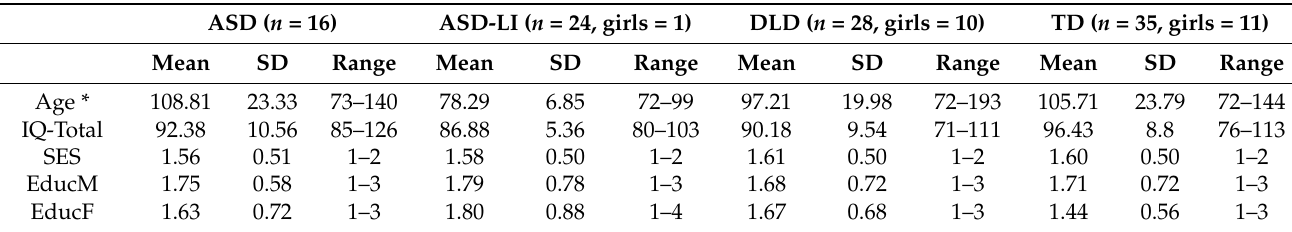
Table 3. Participants’